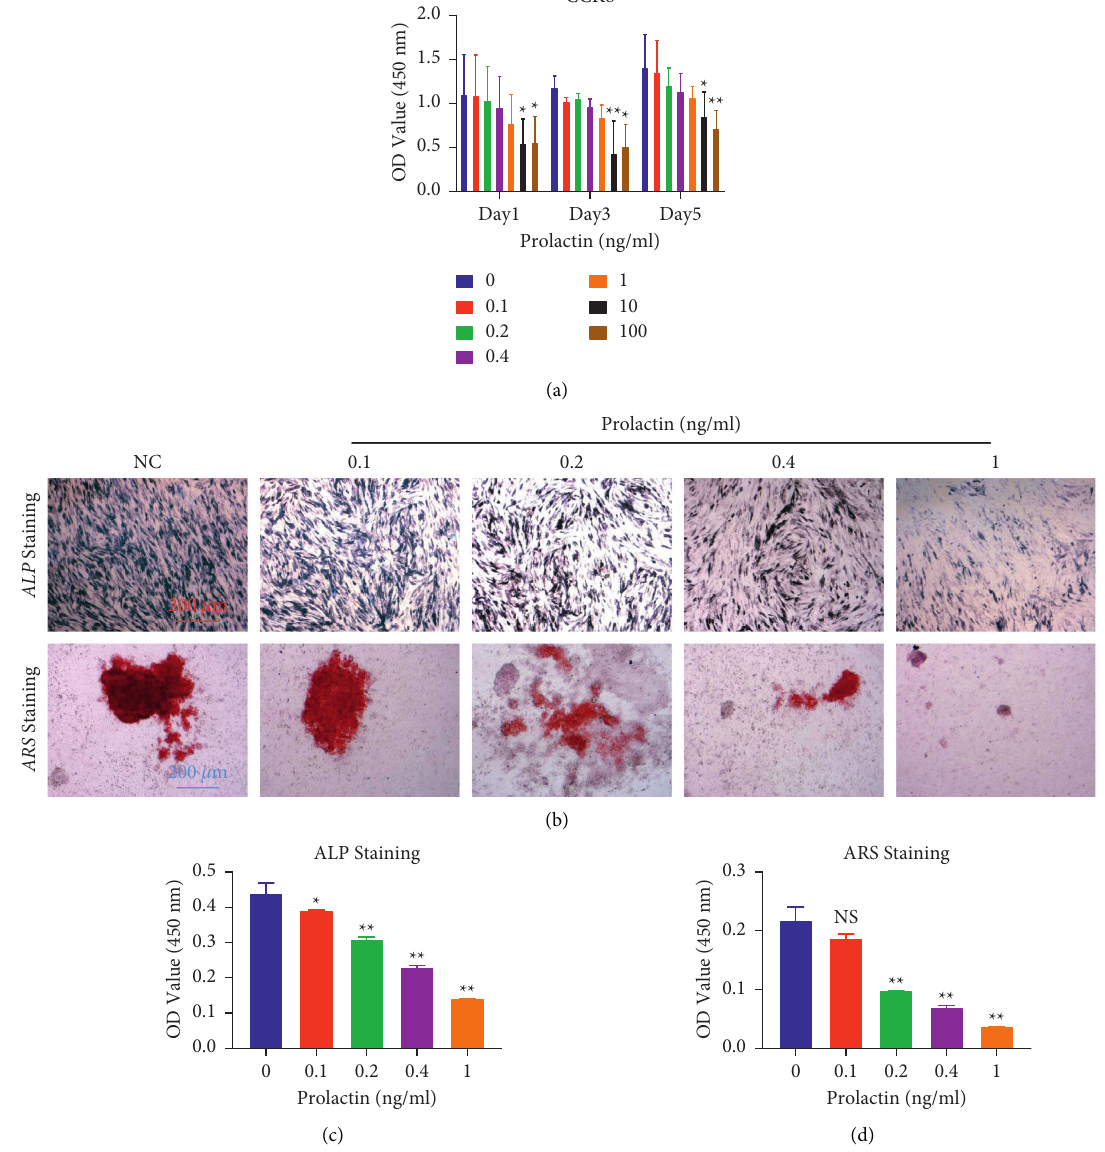
Figure 1: Prolactin inhibited osteoblast differentiation in vitro. (a) A CCK-8 assay was performed to evaluate cell viability. (b) Repre- sentative images of ALP and ARS staining. (c) The ALP-positive cells in each group were quantified. (d) Quantification of ARS-stained cells and mineral nodules. n � 3; scale bar � 200 μ m; # P < 0 . 05, ## P < 0 . 01, # vs the 0 ng/ml group; NS: not statistically significant, ∗ P < 0 . 05, ∗∗ P < 0 . 01, ∗ vs the NC group. ALP, alkaline phosphatase; ARS, alizarin red